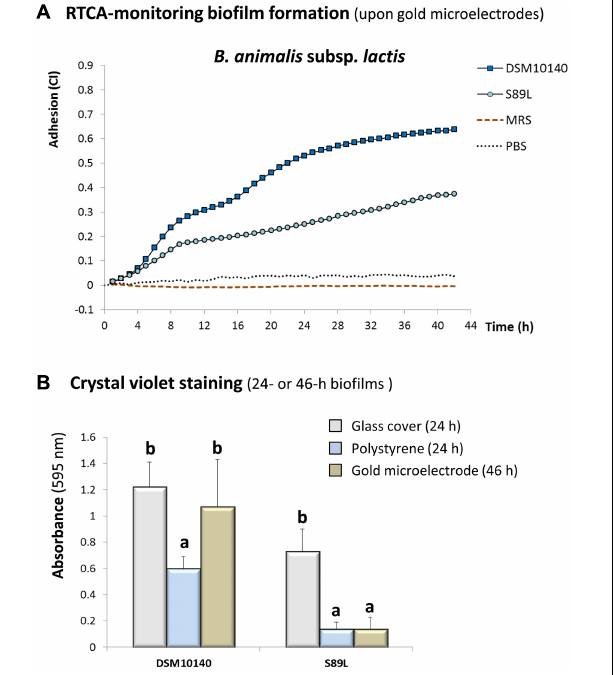
FIGURE 5 | Monitoring in real time the formation of biofilms by strains B. animalis subsp. lactis DSM10140 and S89L upon (gold-microelectrodes) E-plates in the RTCA (real time cell analyzed) equipment (A) . Biofilms formed by the same strains in three abiotic surfaces and stained, at different end-point times, with the crystal violet method; within each strain, bars that do not share a common letter are significantly ( p < 0.05) different (B)